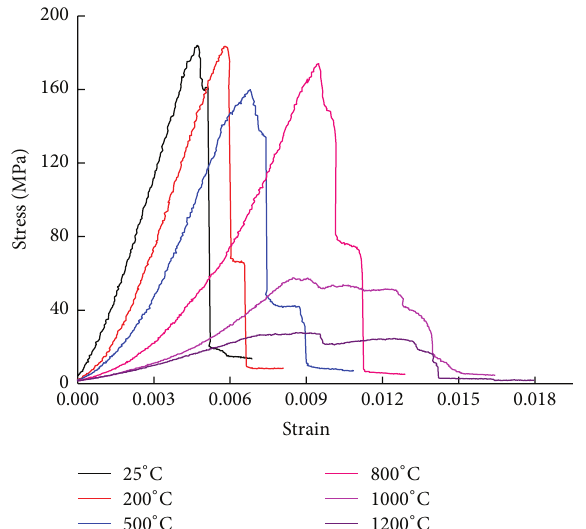
Figure 4: Variation of UCS of rock samples with increasing temper-